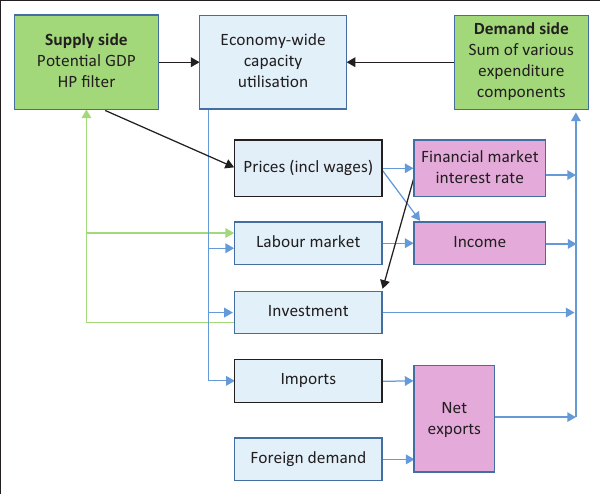
FIGURE 4: Simplified model